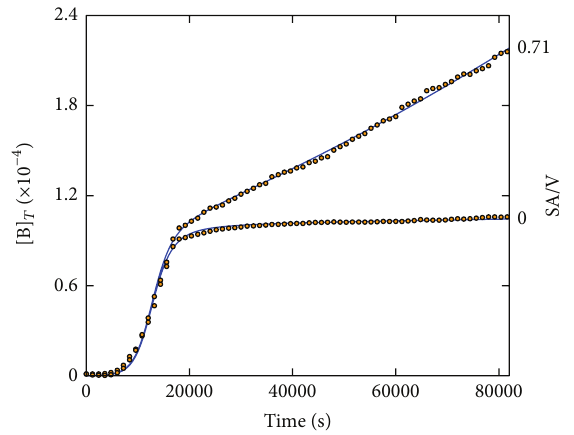
Figure 3: EPEC growth curves at SA/V = 0 .71 and 0cm −1 with V = 1.4 cm 3 in both cases (open circles) best fitted by the CKA model (solid lines). Obtained parameter values: 𝑘 0 = 7 .87 M −1 s −1 , 𝑘 1 = = 1.73 × 10 −3 M −1 s −1 , 𝑘 ( 0.71 ) = 6 .5 5 × 10 −3 s −1 , 1.98 × 10 −4 s −1 , 𝑘 2 3 (0) = 0 s −1 , and 𝑘 = 4.35 × 10 8 M −1 . 𝑘 3 4